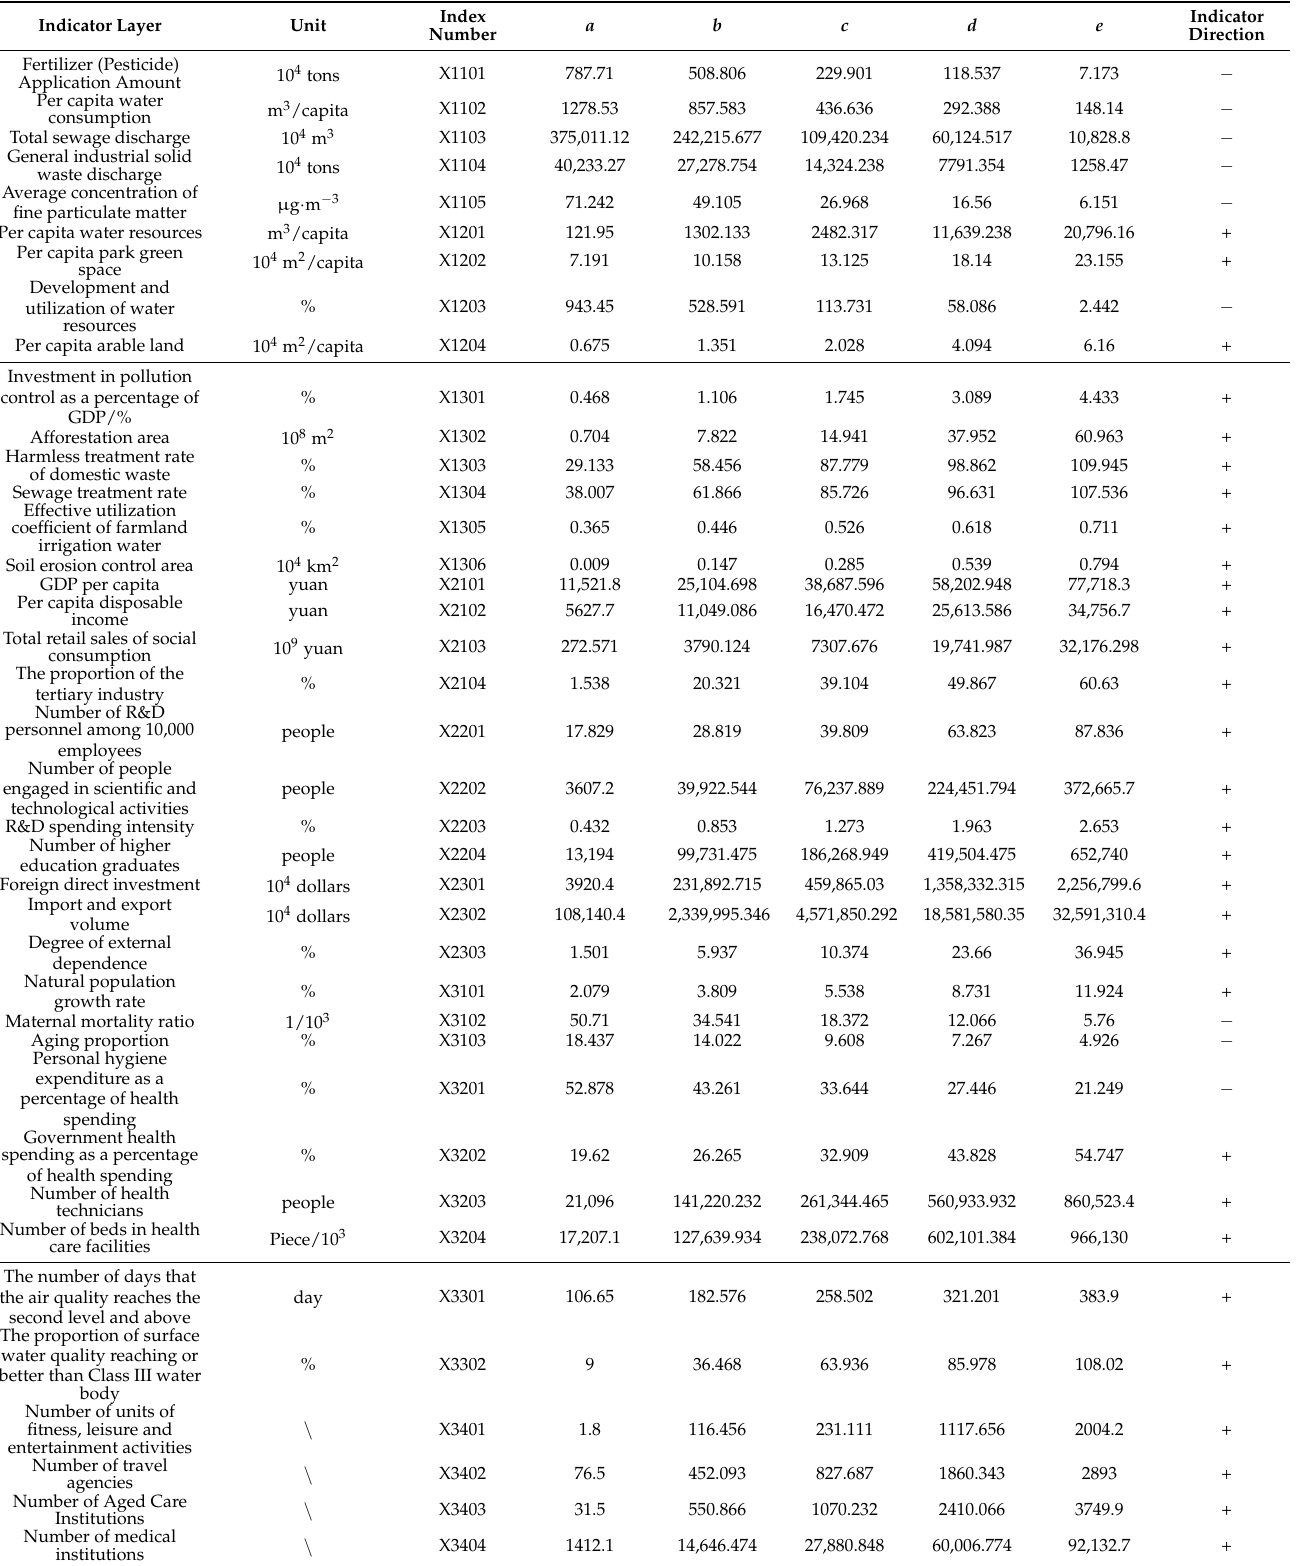
Table 3. The properties of each indicator of the quantitative index system for high-quality develop- ment of public